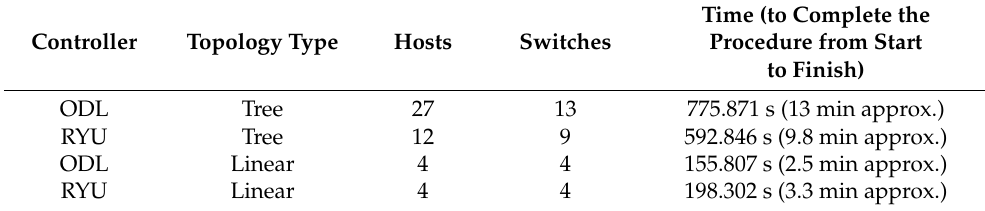
Table 5. Observation to create custom topologies with ODL and Ryu Controllers.